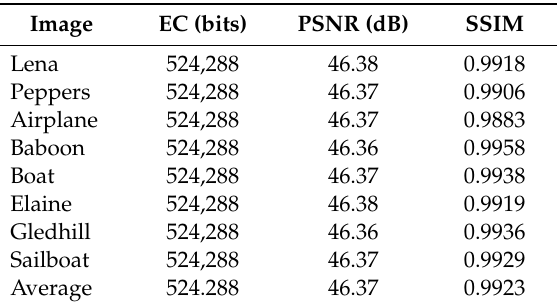
Table 1. Experimental results for grayscale images.